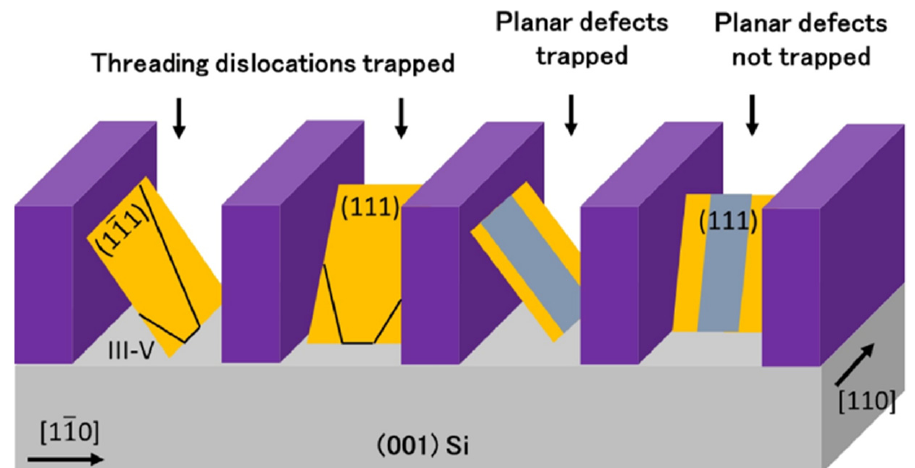
the SiO 2 stripe pattern, coalesced GaAs thin films were regrown on the nanowire arrays. Figure 4a shows a scanning electron microscopy (SEM) image of the resultant coalesced GaAs layer with a flat surface. The surface morphology of 300 nm-thick coalesced GaAs layer measured by atomic-force microscopy (AFM) produced a root-mean-square (rms) of 1.9 nm across a scanned area of 5 × 5 µ m 2 . The APBs were not observed in the GoVS template, which can be explained by the III-V growth on Si {111} plane. A transmission electron microscopy (TEM) image in Figure 4b presents a unique stacking fault trapping. It was shown that a tiara-like structure beneath the SiO 2 sidewall, created by Si undercutting, e ff ectively trapped most of the stacking faults around the interface of GaAs / Si(111). Owing to this unique trapping mechanism, after removing the SiO 2 , the subsequent GaAs overgrowth can be performed with maintaining the ability of defect trapping, as shown in Figure 4c. Although some of stacking faults can escape the tiara-like structure in the thick stacking-disorder regions, the escaped stacking faults can be annihilated by crossing of two stacking faults due to the closely spaced V-groove structure.